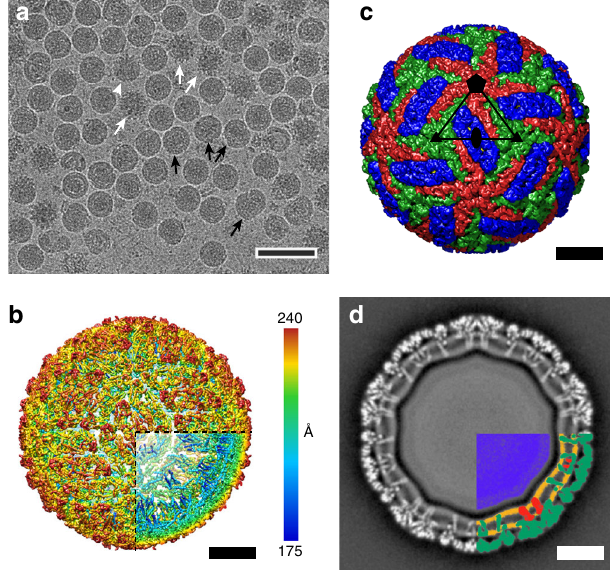
Fig. 1 Structure of TBEV virion. a Cryo-EM image of TBEV virions. The sample contained mature, immature (white arrows), half-mature (white arrowheads), and damaged (black arrows) particles. Scale bar 100 nm. b B- factor sharpened electron-density map of TBEV virion, rainbow-colored according to distance from particle center. The front lower-right eighth of the particle was removed to show the transmembrane helices of E-proteins and M-proteins. c Molecular surface of TBEV virion low-pass fi ltered to 7 Å. The three E-protein subunits within each icosahedral asymmetric unit are shown in red, green, and blue. The three E-proteins in the icosahedral asymmetric unit form unique interactions with each other (for more details, see Supplementary Fig. 2). The black triangle shows the borders of a selected icosahedral asymmetric unit. d Central slice of TBEV electron density map perpendicular to the virus 5-fold axis. The virus membrane is deformed by the transmembrane helices of E-proteins and M-proteins. The lower right quadrant of the slice is color-coded as follows: nucleocapsid — blue; inner and outer membrane lea fl ets — orange; M-proteins — red; E- proteins — green. Scale bars in b , c , and d represent 10